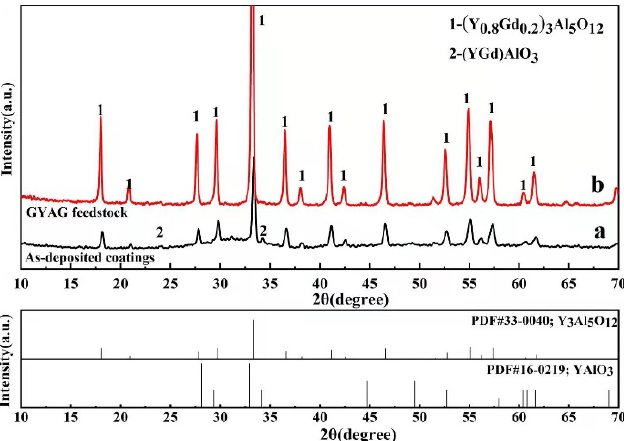
Figure 4. XRD patterns of the as-deposited GYAG coatings ( a ) and GYAG feedstock ( b ) .